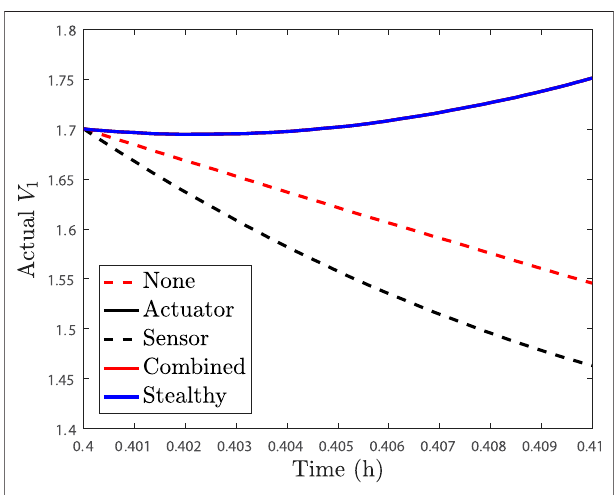
FIGURE 1 | Actual V 1 pro fi les over one sampling period after 0.4 h of operation for the process example described above in the presence of no attacks ( “ None ” ), only actuator cyberattacks ( “ Actuator ” ), only sensor attacks ( “ Sensor ” ), the baseline combined actuator and sensor attacks ( “ Combined ” ), and the stealthy combined sensor and actuator attack ( “ Stealthy ” ).Theplots fortheactuator attack,baseline combinedactuator and sensor attack, and stealthy sensor and actuator attack are overlaid due to all having the same input (the false actuator signal) over the sampling period.